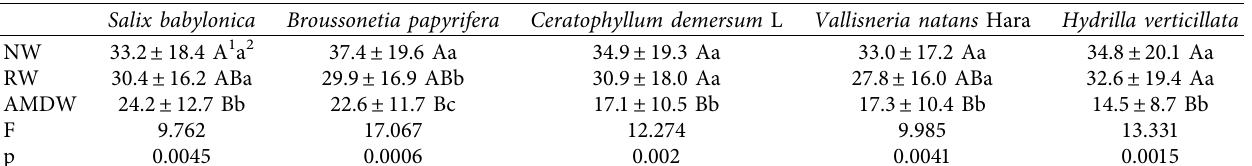
Figure 5: The degradation trend of the five plant litters in NW, AMDW, or RW. Salix babylonica and Broussonetia papyrifera are native dominant woody species at the local shore; Vallisneria natans Hara , Hydrilla verticillata, and Ceratophyllum demersum L are native dominant submerged plants in the Huaxi Reservoir. Table 2: The Duncan multiple comparison of the litter decomposition rate among NW, RW, and AMDW (%).